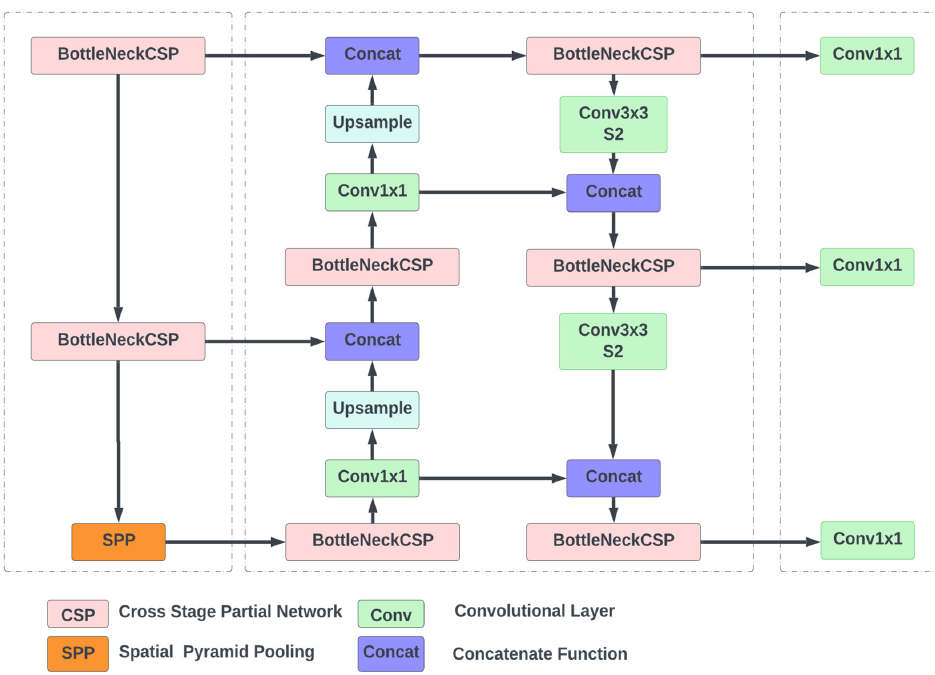
Figure 4. YOLOv5s network